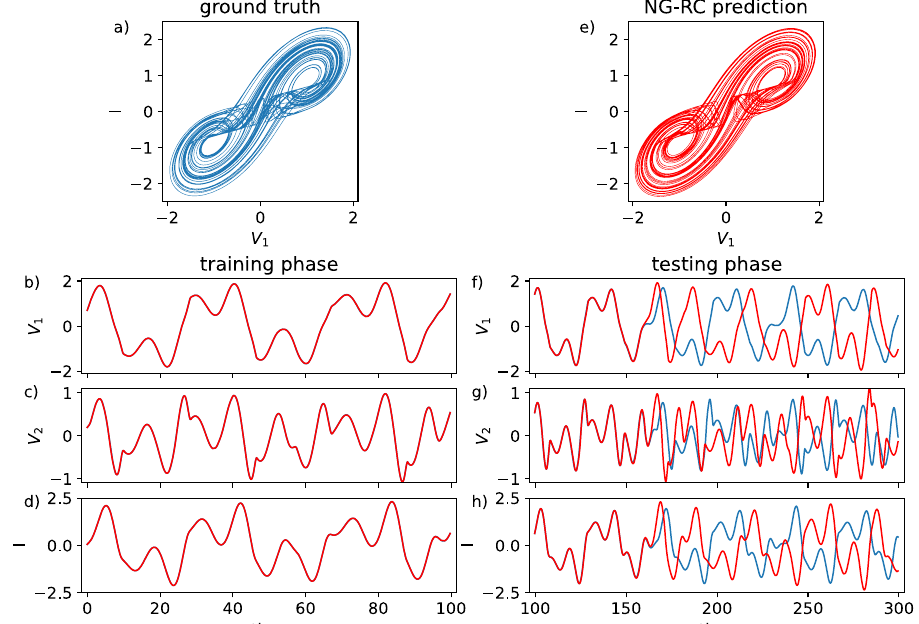
Fig. 3 Forecasting the double-scroll system using the NG-RC. True ( a ) and predicted ( e ) double-scroll strange attractors. b – d Training data set with overlayed predicted behavior. f – h True (blue) and predicted datasets during the forecasting phase (NRMSE = 4.5 ± 1.0 × 10 − 3 ).